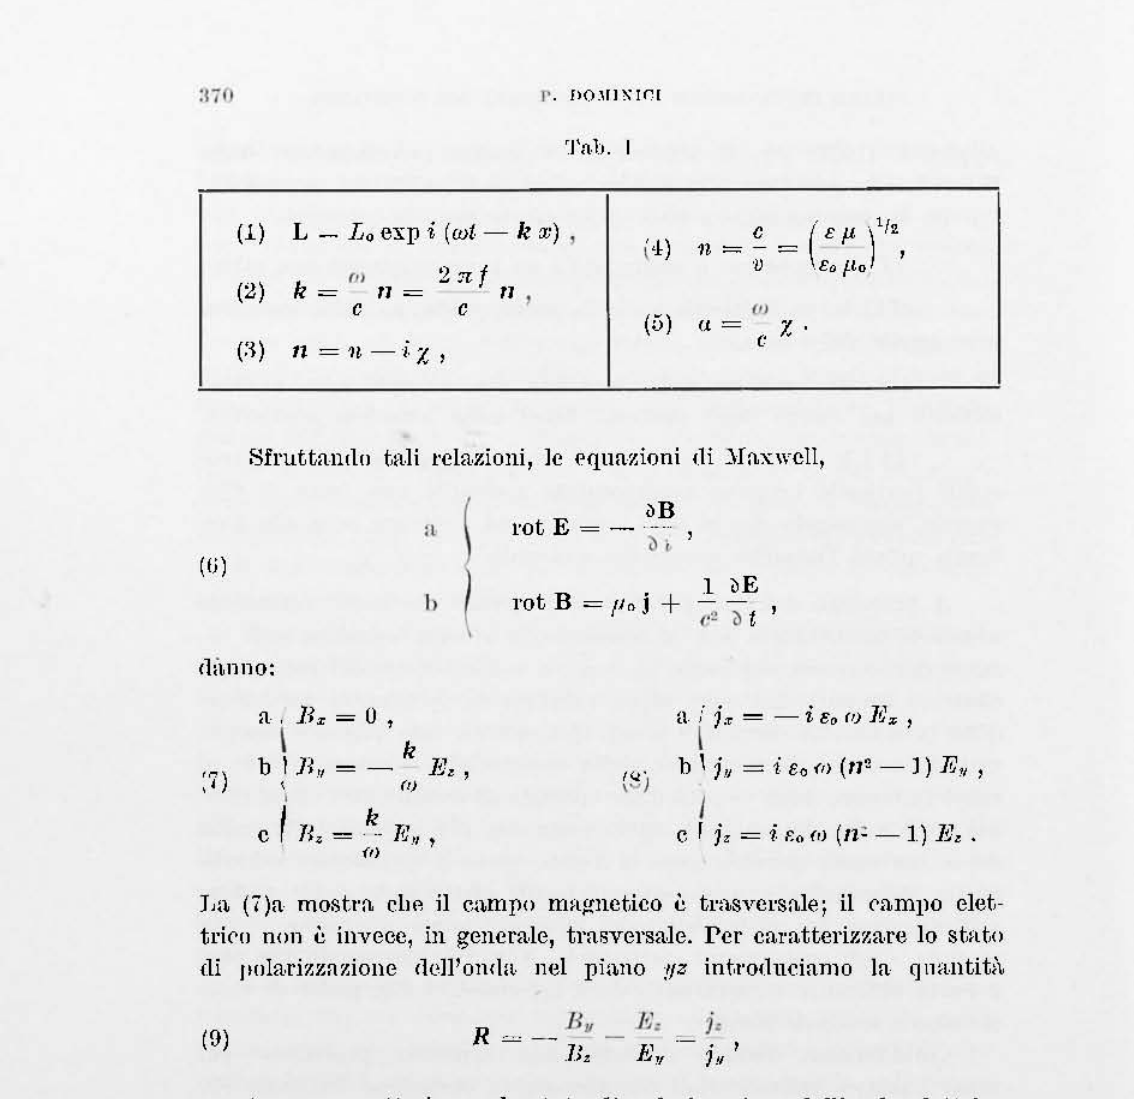
mentre lwr camtt.erizzare lo st.at.o di polarizzazione dell'onda elettriea, nel piano .rll introlllleiamo la· qllnntitù s (lO) A valori reali oppure eOilllllessi di R e S corrisponde una polarizza zione lineare oppUl"e ellittica; in llart.icol;ue, si 1m polarizzazione cir cola,re ller R o S pari a ±